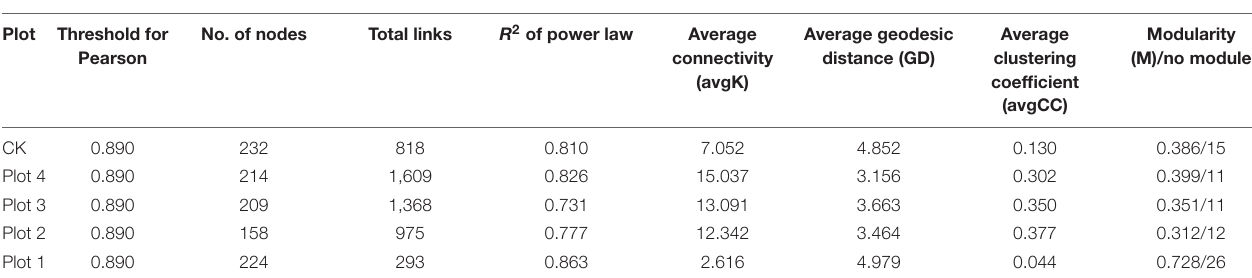
FIGURE 5 | Soil fungal MENs and interaction. Nodes were colored by different modules; the size represents the node degree (Connectivity). The connection line represents the interaction between the target level on phylum, with blue representing positive and red representing negative. TABLE 2 | Topological properties of the empirical ecological